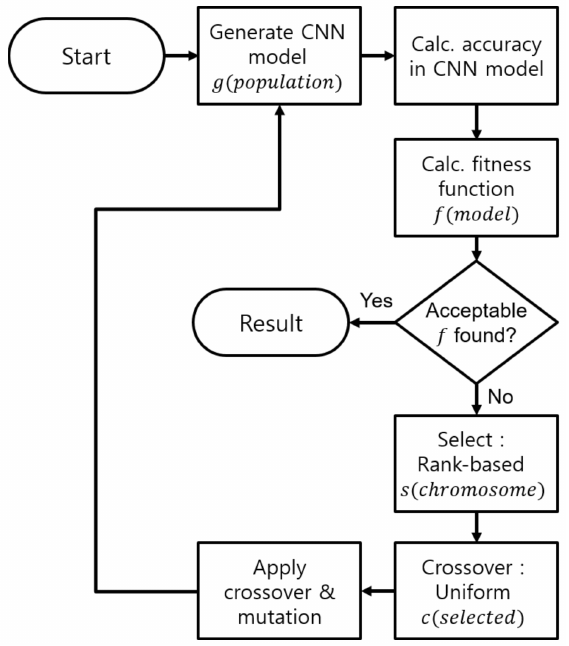
Figure 3. Block diagram explaining the process of our Genetic Algorithm